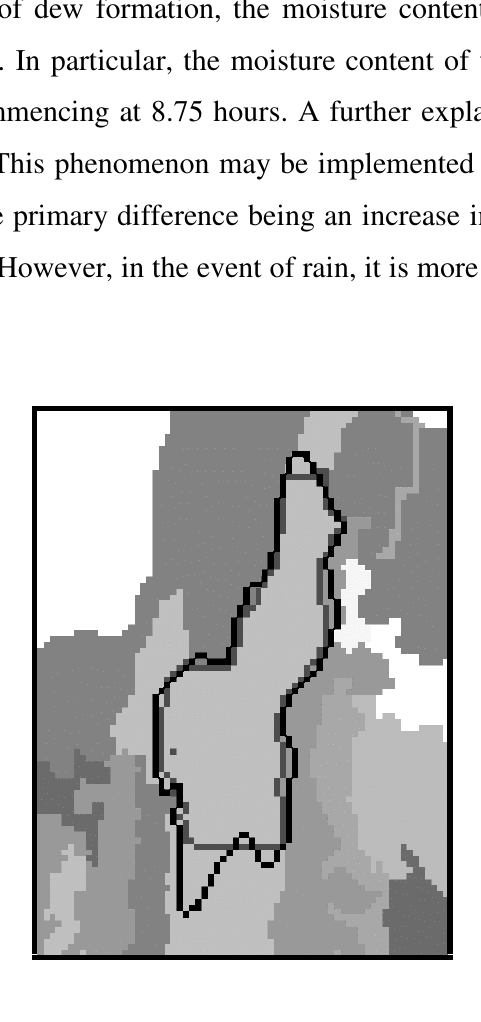
Figure 5. Fire boundary after 9.5 hours generated by the simulation model compared to the observed fire boundary (black cells) for the Mahlala area of